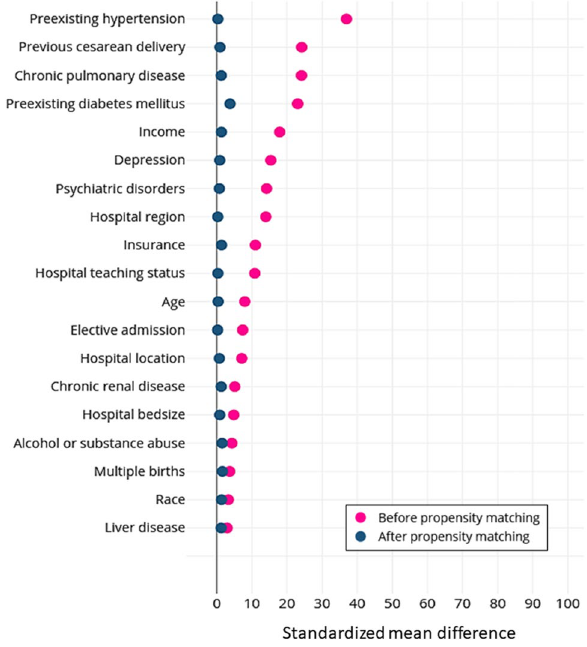
Figure 1. Standardized differences between variables before and after propensity matching for obese versus non-obese women. Note: Vertical lines represent the acceptable range of standardized difference after propensity score matching